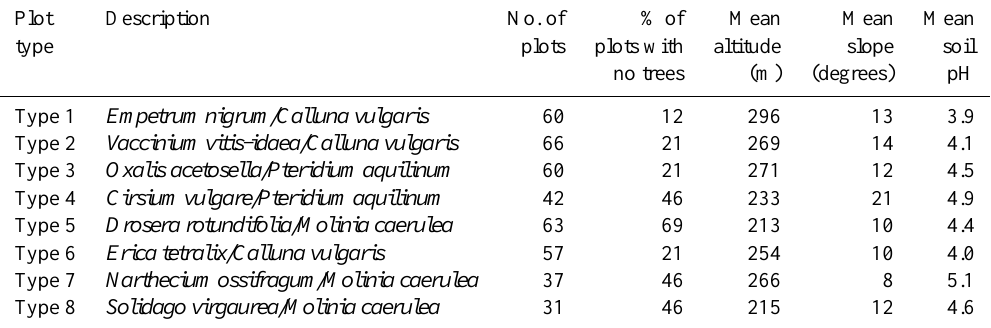
Table 4. Summary of plot types identified by indicator species analysis. Plot Description No. of % of Mean Mean Mean type plots plots with altitude slope soil no trees (m) (degrees)